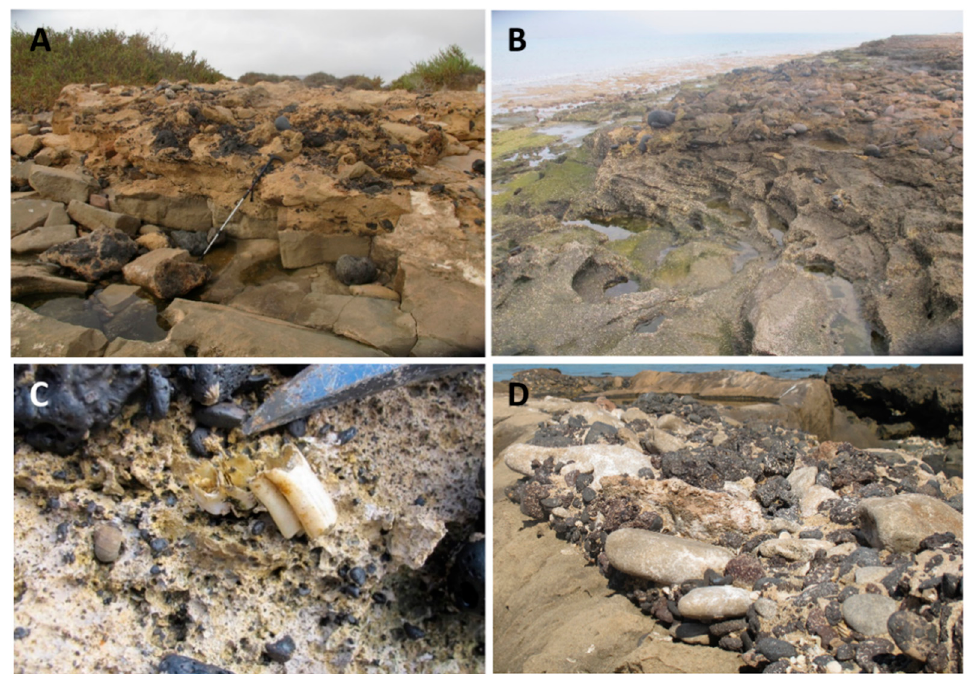
Figure 3. Photographs of La Graciosa 1730 ± 30 BP deposit: ( A ) conglomerate overlying calcarenites (matrix-supported facies); ( B ) the deposit is dipping seawards; ( C ) goat tooth found in the deposit; and ( D ) clast-supported facies of the conglomerate.